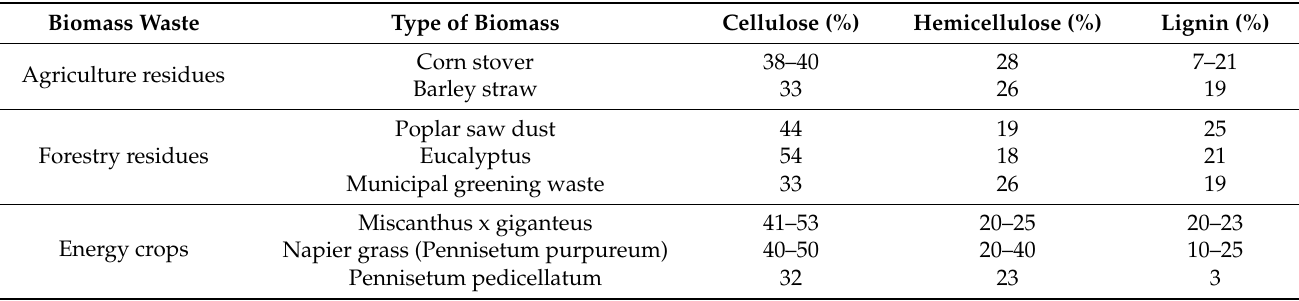
Table 5. Chemical compositions of various biomass residues